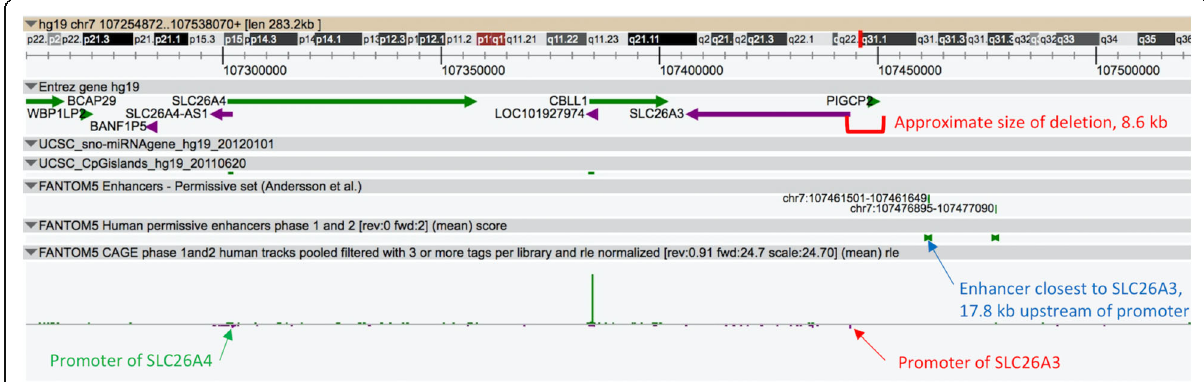
Fig. 1 SLC26A3 (purple arrow) and SLC26A4 (green arrow) genes on chromosome 7q22.3-q31.1 (marked with red bar) are shown. The promoters of these genes are marked with arrows and the SLC26A3 deletion causative for CLD with a red square bracket. The two nearest enhancer elements are shown, of which one is 17.8 kb upstream of SLC26A3 ; none is near SLC26A4 . The 8.6 kb deletion responsible for CLD extends upstream only about half-way to the nearest enhancer element. The image is a screen capture from the FANTOM5 database